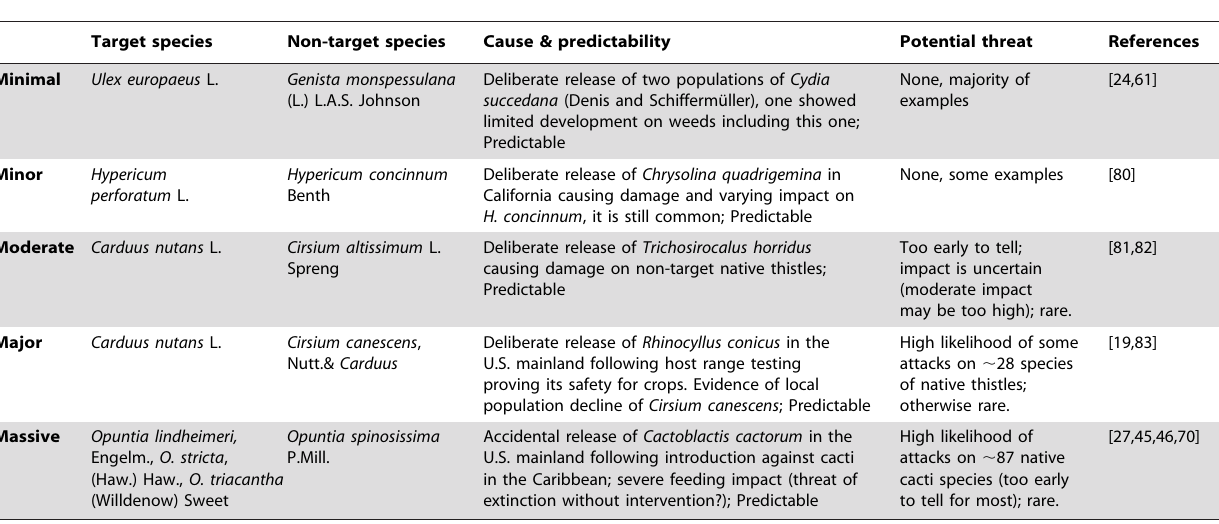
Table 3. Examples of each magnitude of non-target impact on plants from weed classical biological control agents.